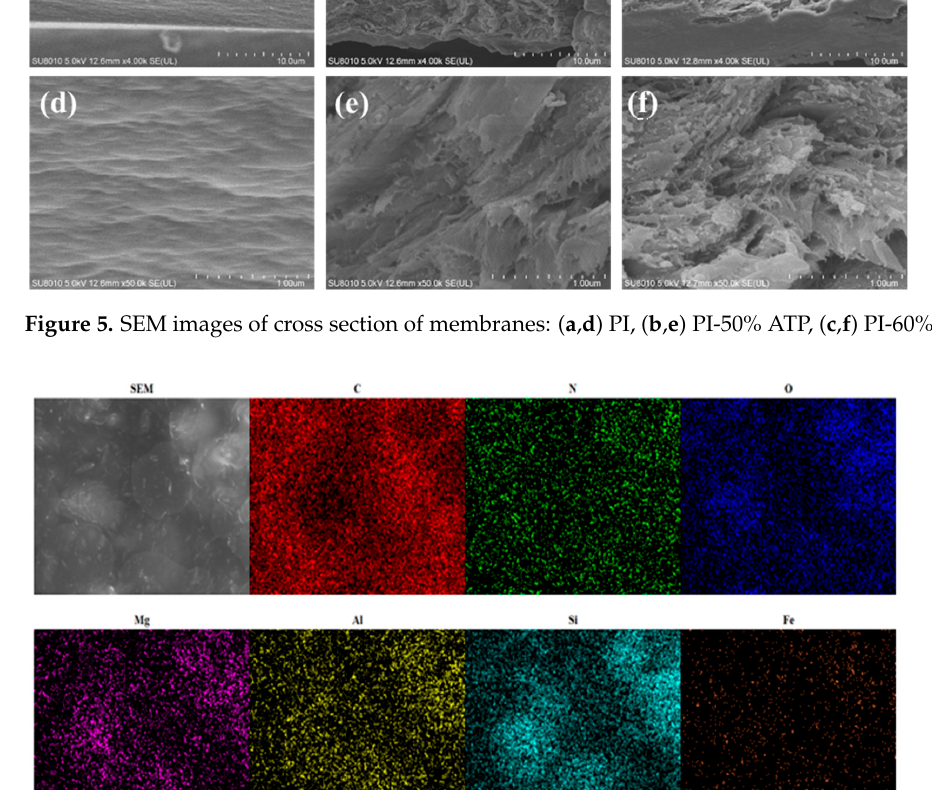
Figure 5. SEM images of cross section of membranes: ( a , d ) PI, ( b , e ) PI-50% ATP, ( c , f ) PI-60%ATP.